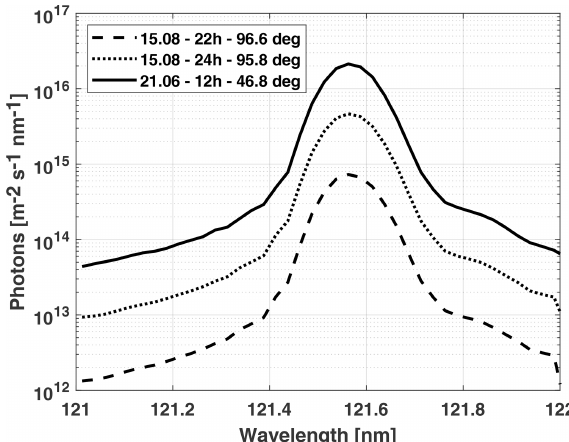
Figure 2. Estimated photon flux for the Lyman- α line for 21 June at 12:00h (UT) and 15 August at 22:00 and 24:00h (UT) at 85km altitude. Solar zenith angles used in the estimation included in the label are from the International Reference Ionosphere (IRI) model